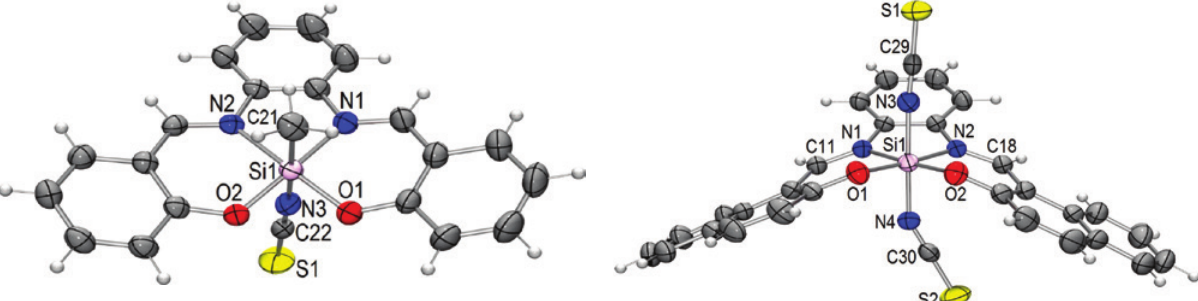
Figure 3: ORTEP view of the asymmetric unit of complex 14 in crystal form. Selected bond lengths [Å] and angles [ ° ]: Si-O1 1.7306(15),